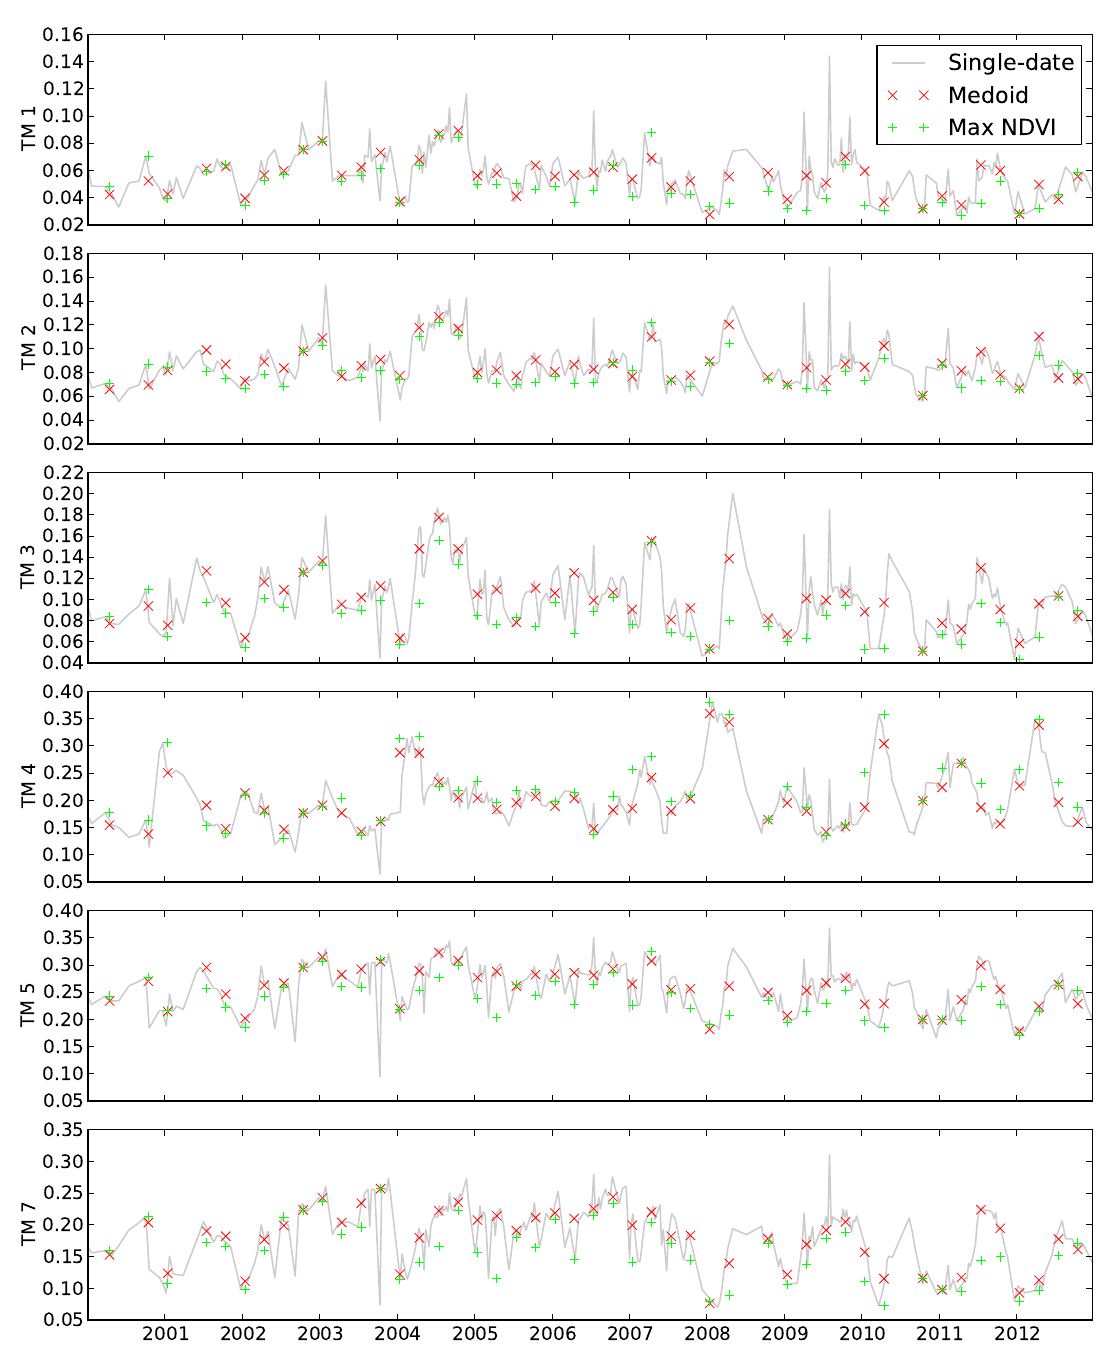
Figure 5. Time series of reflectance for all Landsat TM/ETM+ reflective bands, for the grassland example pixel. Seasonal values are marked as crosses. The green crosses are the seasonal reflectance values as selected by the max NDVI method, while the red crosses are the seasonal reflectance values selected using the